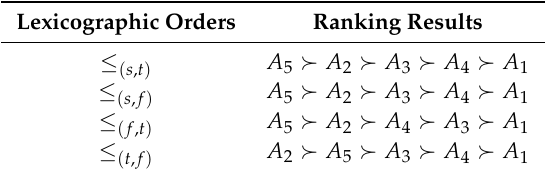
Table 4. Ranking results given by different lexicographic orders in Case